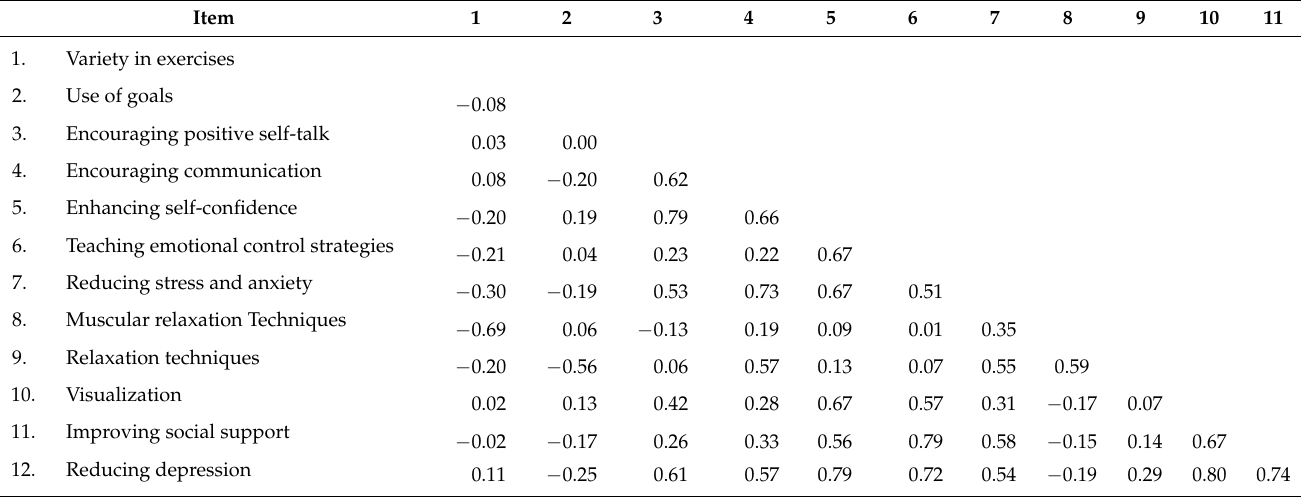
Table 4. Spearman correlations among responses to Patient Behavioral Checklist items.